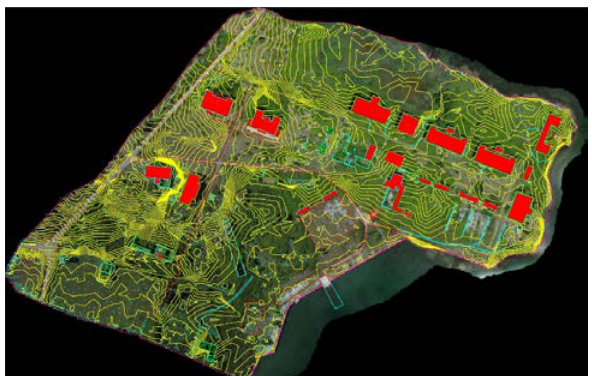
Figure 9. Contour